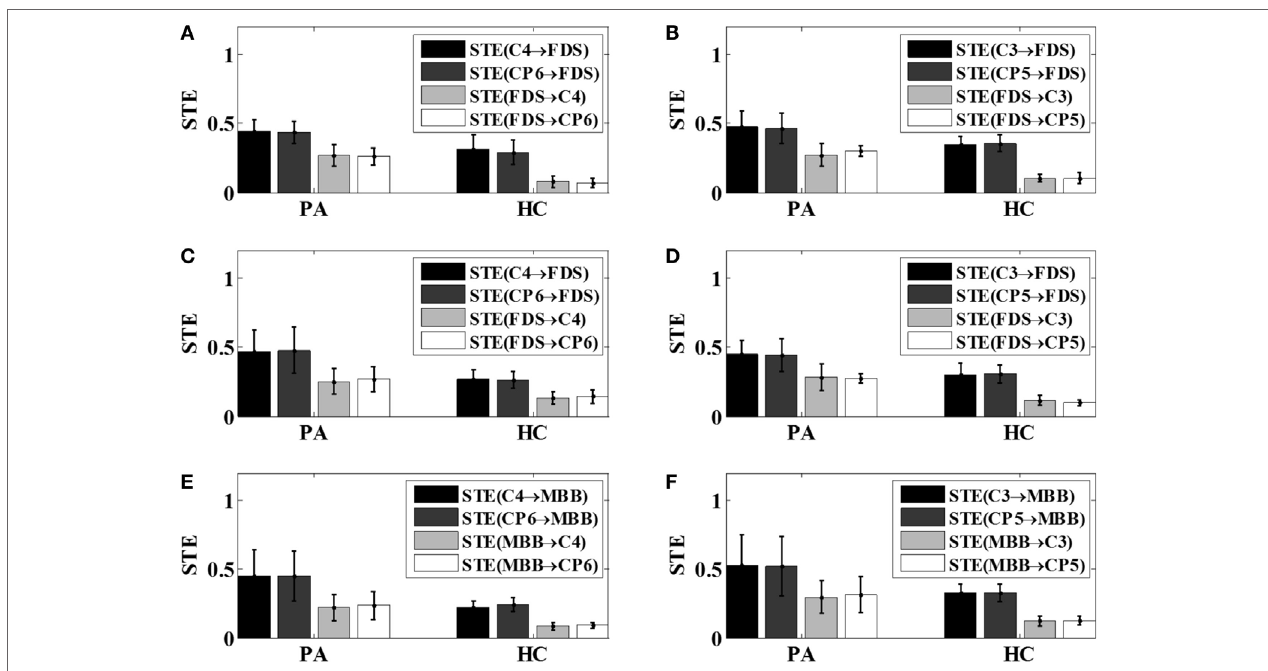
FigUre 5 | The bi-directional STEs between electroencephalogram and electromyography with respect to different tasks. (a) Left hand 5 kg gripping; (B) right hand 5 kg gripping; (c) left hand 10 kg gripping; (D) right hand 10 kg gripping; (e) left hand elbow flexion; (F) right hand elbow flexion. PA, patients; HC, healthy controls; STE, symbolic transfer entropy.